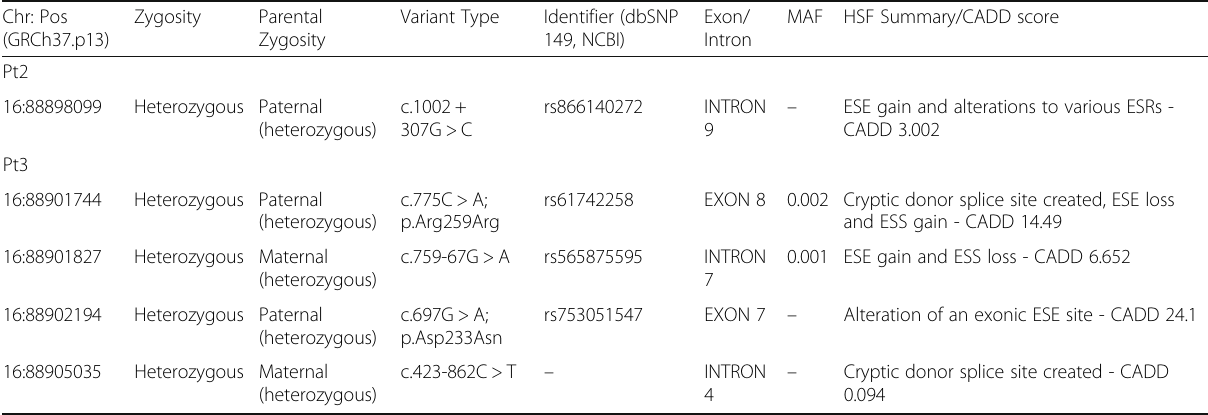
Table 2 GALNS nucleotide sequence variants with potential significance in the generation of the GALNS aberrant splicing products detected in Pt2 and